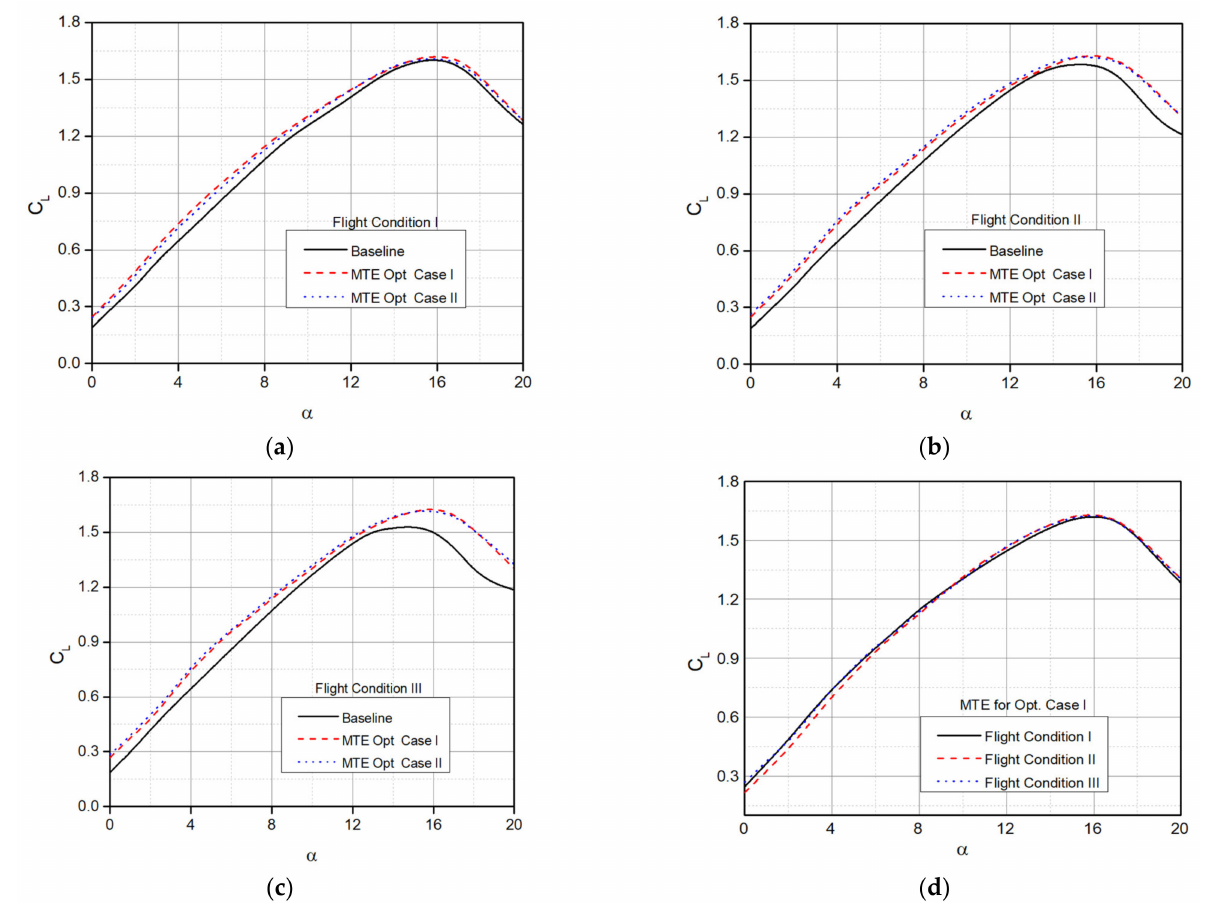
Figure 20. Lift coefficients versus angle of attack at two optimized design configurations; ( a ) the variations of lift coefficients with the angles of attack at Flight Condition I ( b ) the variations of lift coefficients with the angles of attack at Flight Condition II; ( c ) the variations of lift coefficients with the angles of attack at Flight Condition III; ( d ) the lift coeffi-cient variations for all three flight conditions for Opt. Case